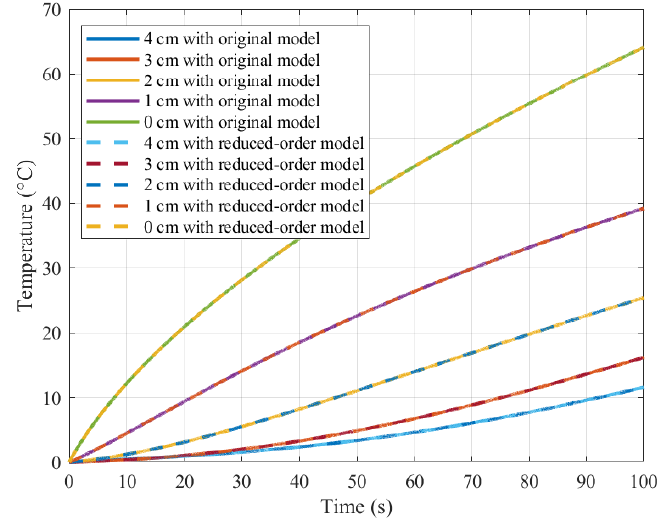
Figure 7. Comparison between the reduced-order model and original model for the temperature rise curves at 4 cm, 3 cm, 2 cm, 1 cm and 0